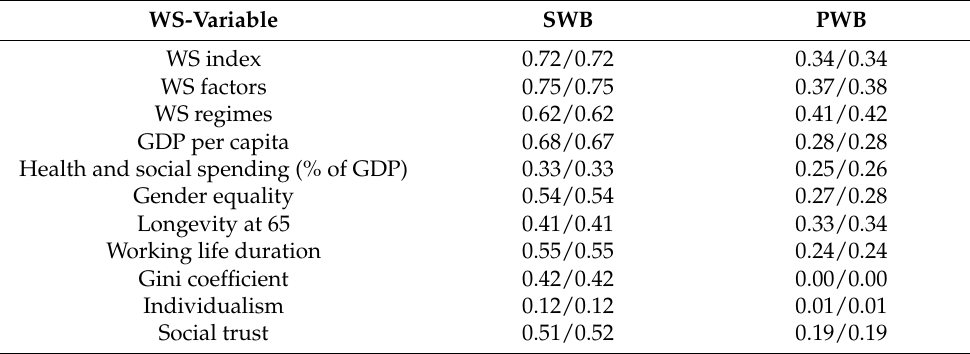
Table A5. Country-level R-squared (Snijders/Bosker